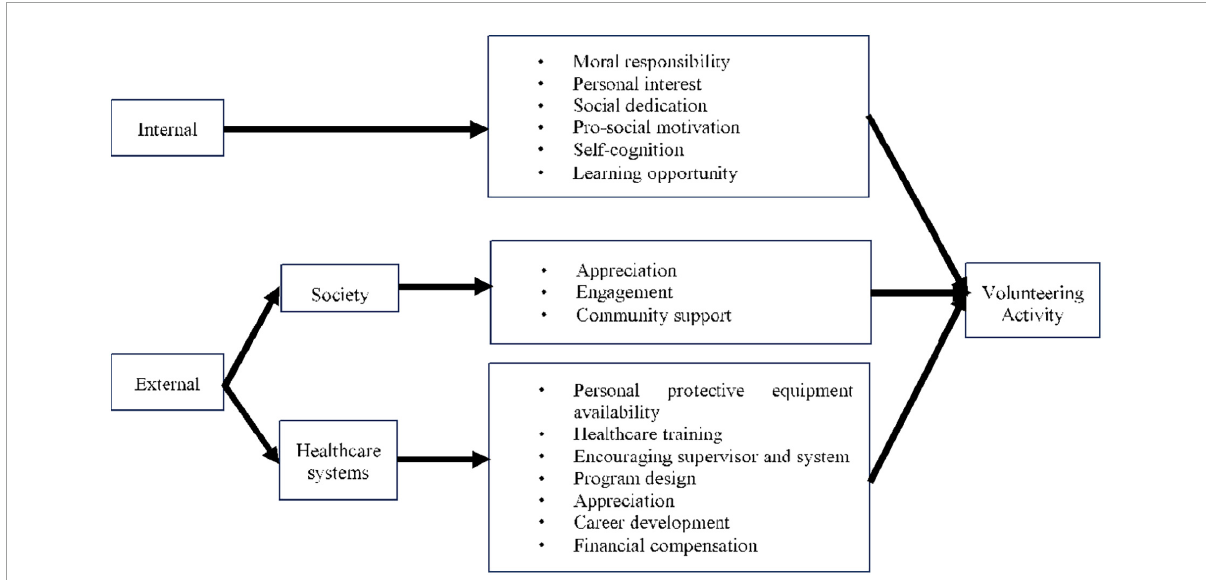
FIGURE4 Proposed Model of Volunteering activity in Health Professional